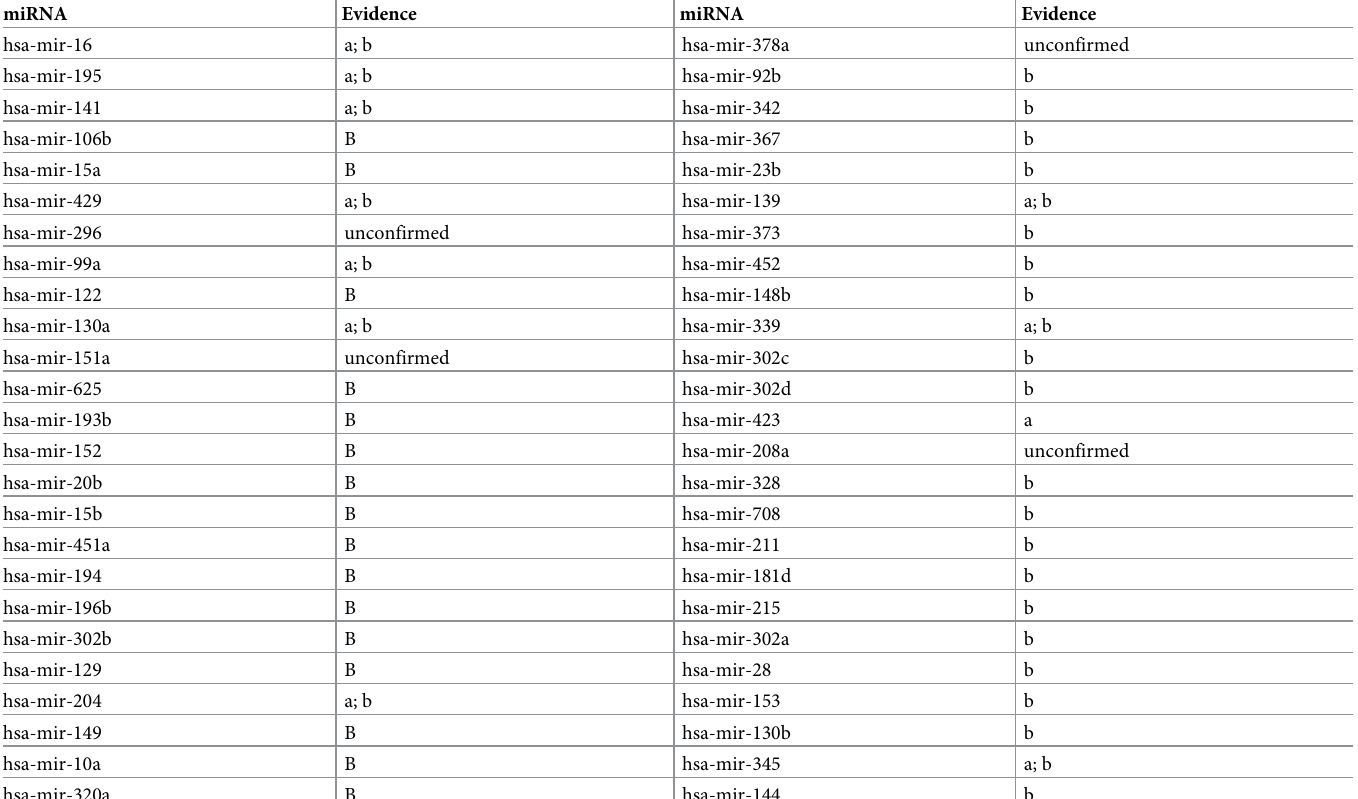
Table 3. The top 50 potential miRNAs associated with lung